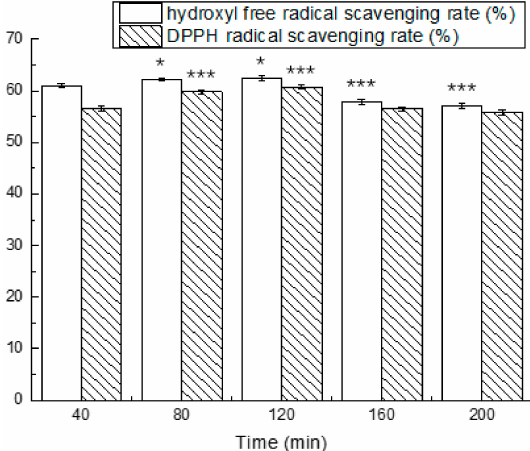
Figure 6. Effects of simulated intestinal fluid on the hydroxyl free radical scavenging rate and DPPH radical scavenging rate at different times. The asterisks (*) indicate significant differences (*** p < 0.001, extremely significant; * p < 0.05, significant.) of antioxidant activity in the simulated intestinal fluid during different times compared to 40 min. Mean values ( n = 3) ± standard error are